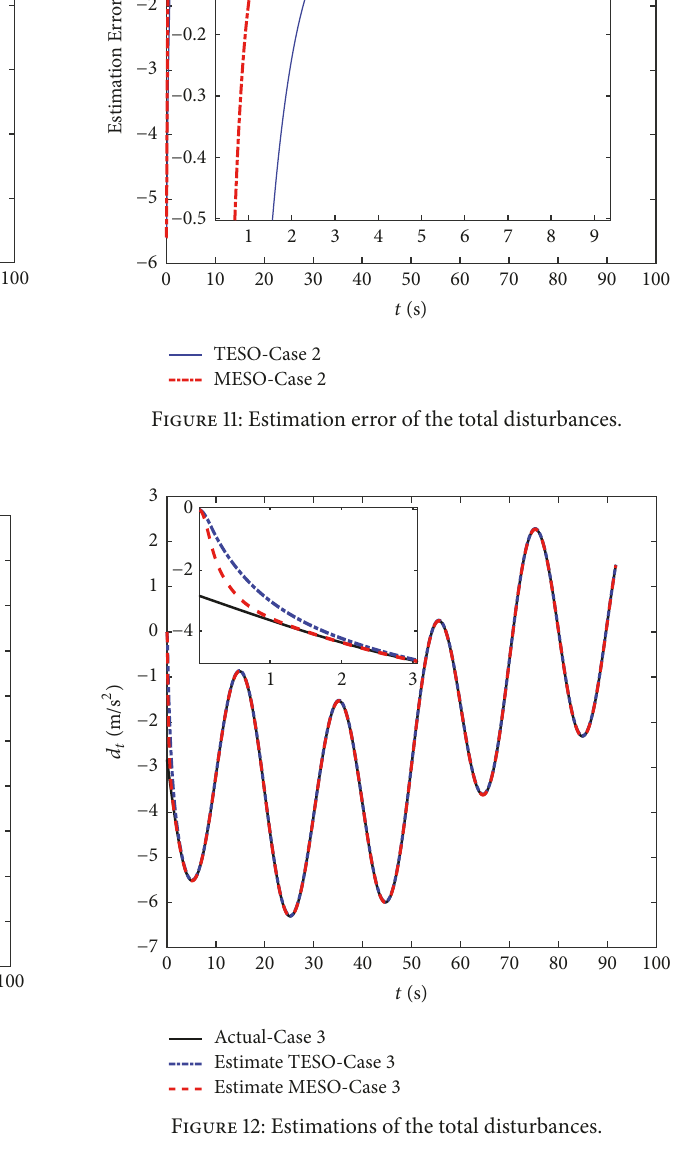
Figure 10: Estimations of the total disturbances.